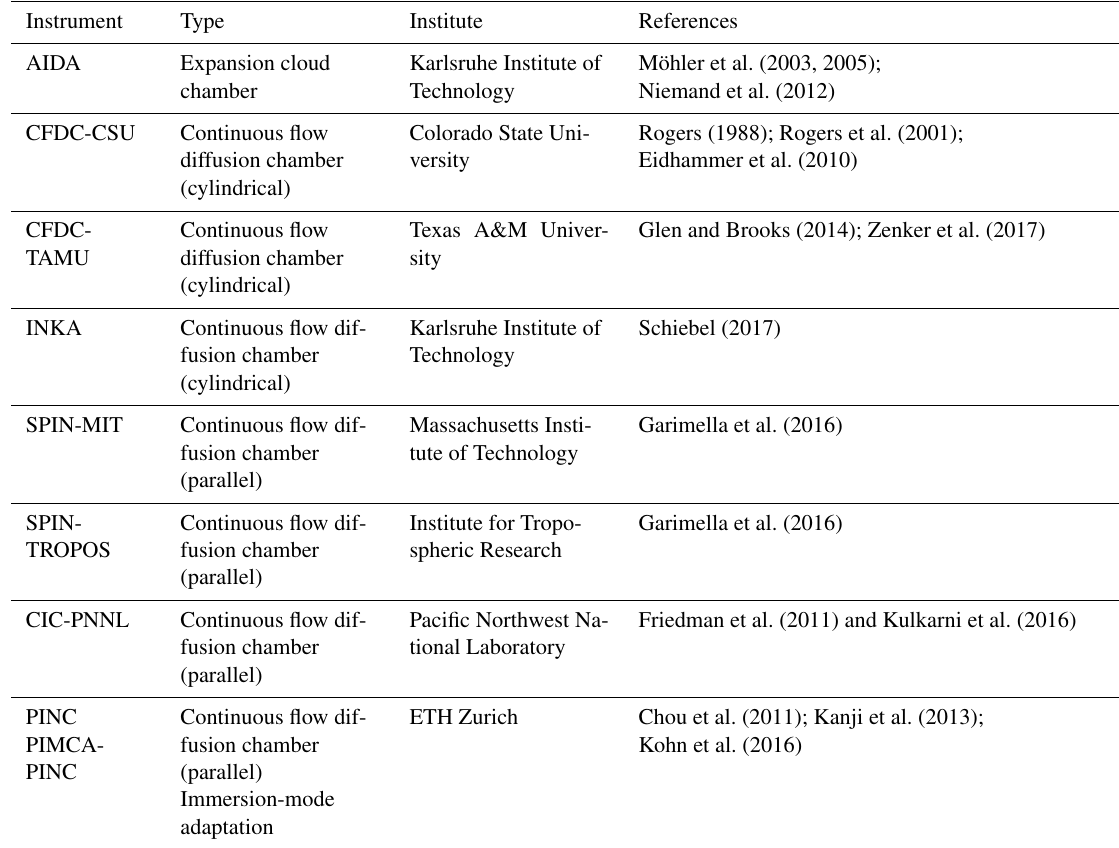
Table 1. Direct processing INP